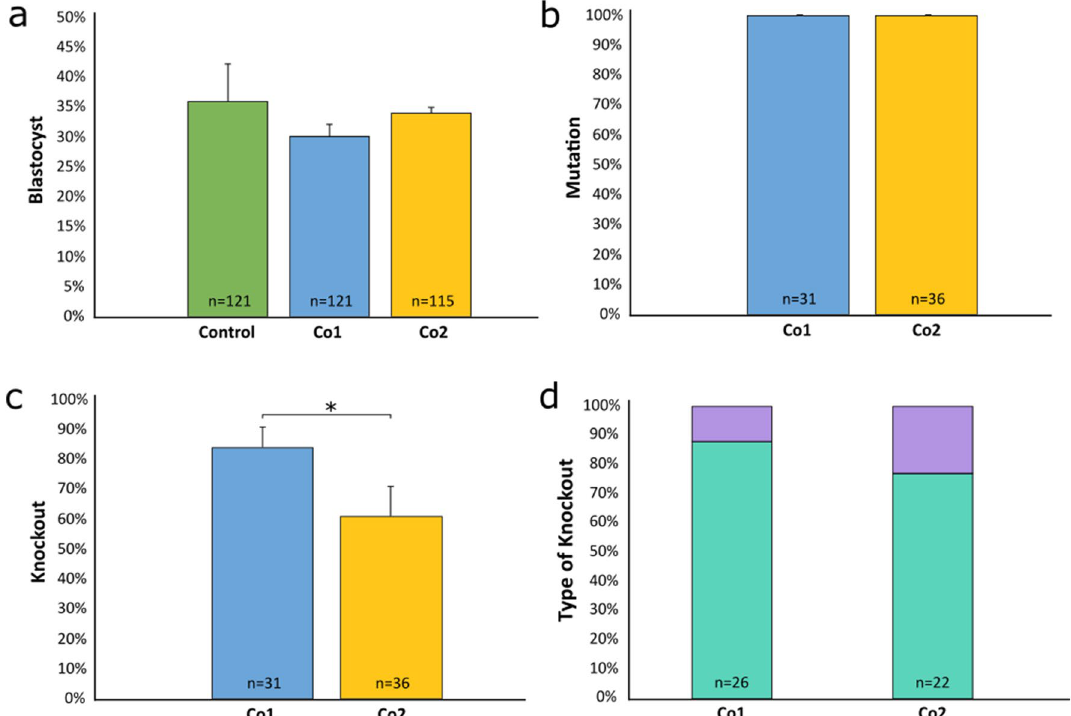
Figure 2. Comparison of uninjected and microinjected zygote development rates and mutation and knockout efficiencies. Zygotes were microinjected with Cas9 protein and either linc 5 ′ g1 and linc 3 ′ g1 (Co1), or linc 5 ′ g2 and linc 3 ′ g1 (Co2), at 6 h post insemination. ( a ) Percentage of uninjected control (green) and microinjected zygotes that reached the blastocyst stage of development. ( b ) Mutation rates and ( c ) knockout rates in embryos injected with gRNA/Cas9 ribonucleoproteins for Co1 (blue) and Co2 (yellow) injection groups. Blastocysts were classified as mutated if a mutation occurred in at least one target site. ( d ) Type of lincRNA#1 knockout (%) in injected embryos. Bi = biallelic (aqua); Mosaic (purple). Error bars = SEM. * P < 0.05.